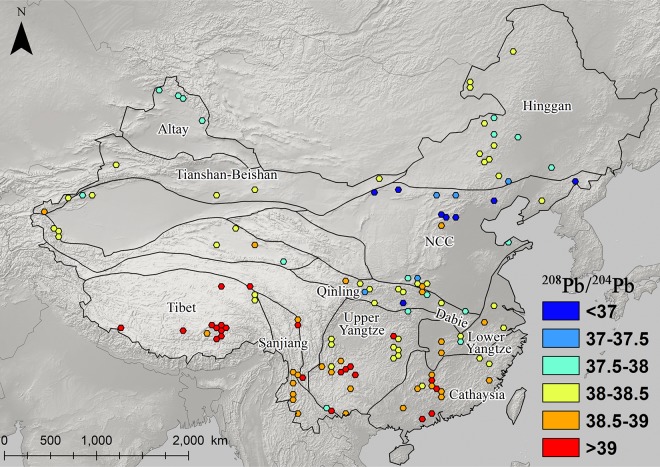
Map of 208Pb/204Pb ratios for galena ores (n = 2,104).